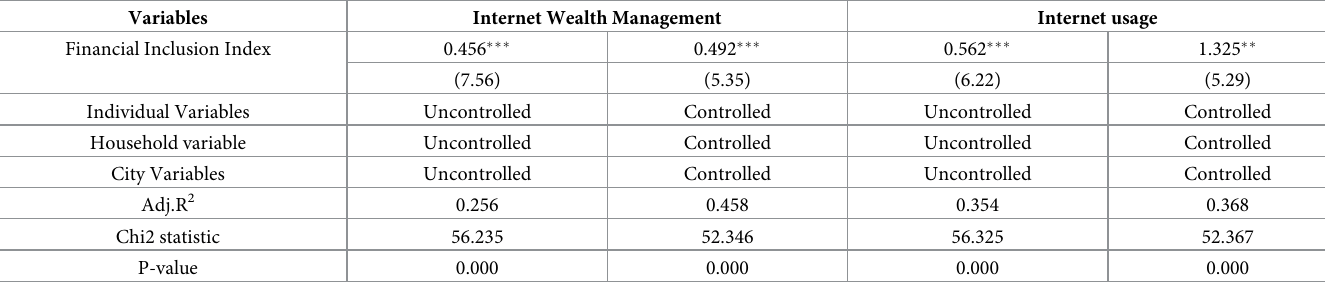
Table 4. Impact of financial inclusion development on willingness to use the Internet.